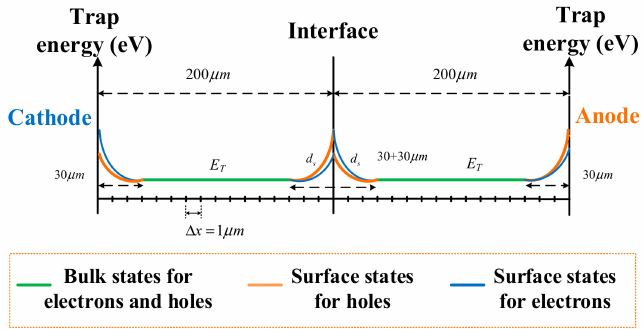
Figure 5. Schematic of the spatial grid and trap energy distribution used for